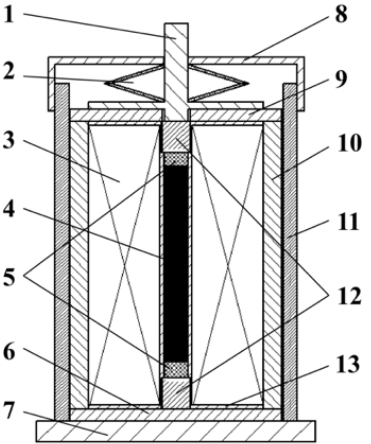
Figure 1. GMA structure: 1. output rod; 2. disc spring; 3. drive coil; 4. GMM bar; 5. permanent magnet; 6. lower guide ring; 7. base; 8. upper end cap; 9. upper permeable ring; 10. permeable sleeve; 11. outer wall sleeve; 12. permeable sheet; 13. coil.